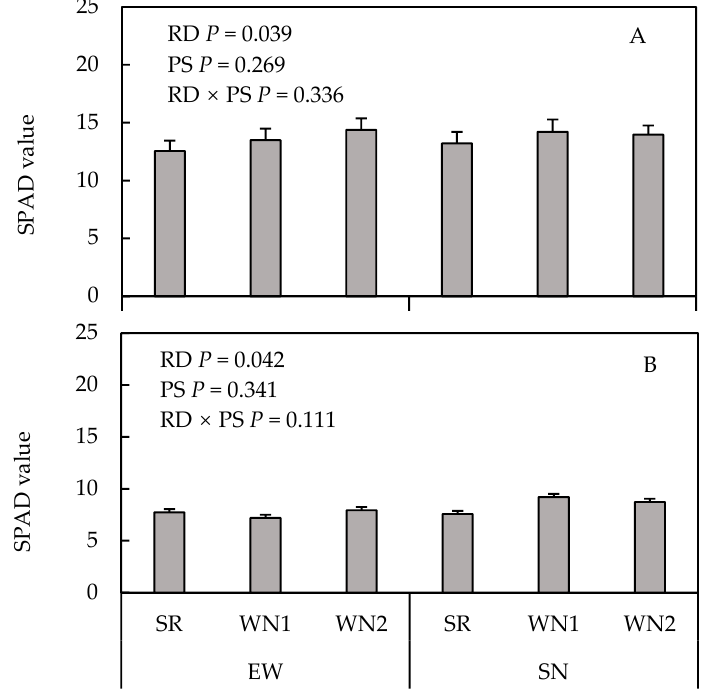
Figure 5. SPAD value of husk leaf at days after silking (DAS) 12 ( A ) and DAS 40 ( B ) of maize under two row directions (RD) and three plant spacings (PS) (EW and SN indicate row direction of east to west and south to north, respectively. SR indicates single rows spaced at 65 cm; WN1 indicates 40 cm twin rows spaced at 90 cm between the paired rows of narrow–wide rows; and WN2 indicates 40 cm twin rows, spaced at 160 cm between the paired rows of narrow–wide rows.). Bars denote the SE of the mean ( n = 3).